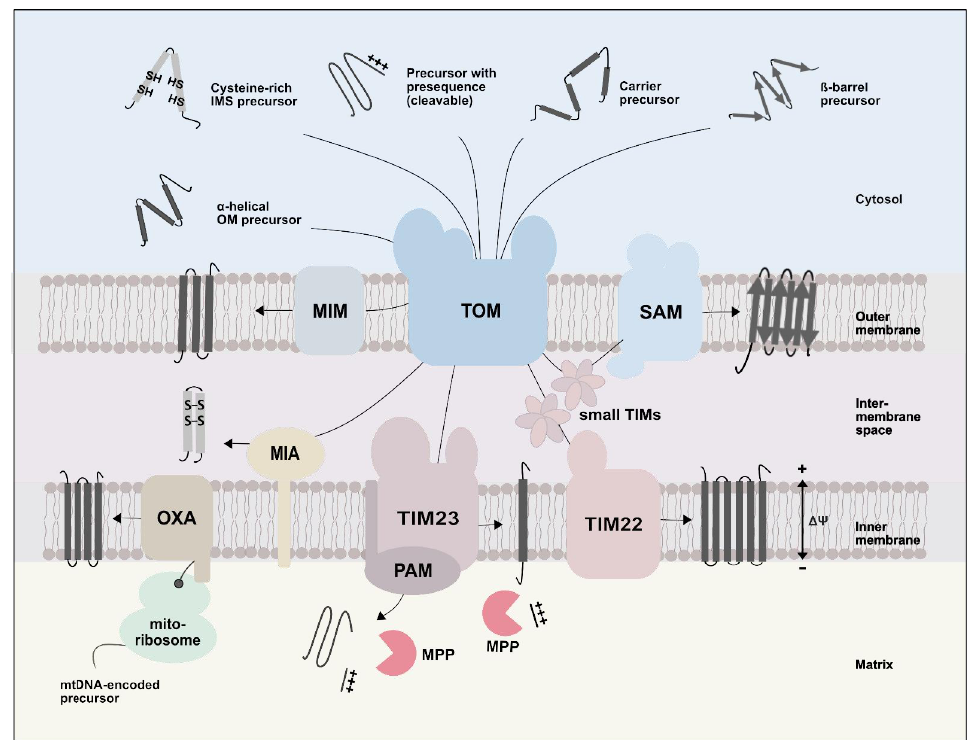
Figure 2. Protein import pathways into mitochondria. Mitochondria have to import the majority of their proteins, which are synthesized as precursors on cytosolic ribosomes. The translocase of the outer membrane (TOM) forms the general entry gate for mitochondrial precursor proteins. After passing the TOM channel, β -barrel precursors are guided by small TIM chaperones of the inter- membrane space to the sorting and assembly machinery complex (SAM), which mediates their fold- ing and insertion into the outer membrane. The presequence translocase of the inner membrane (TIM23) transports precursors with a cleavable presequence into and across the inner membrane. Translocation into the matrix depends on the ATP-depending activity of the presequence trans- locase-associated motor (PAM). After import, mitochondrial processing peptidases (MPP) remove the cleavable presequence. In the carrier pathway, small TIM chaperones transfer the hydrophobic carrier precursor from the TOM complex to the carrier translocase (TIM22), which inserts them into the inner membrane. The membrane potential (Δψ) drives protein import into and across the inner membrane. The mitochondrial intermembrane space import and assembly machinery (MIA) directs cysteine-rich precursors into the IMS and mediates their oxidative folding. The mitochondrial im- port machinery (MIM complex) inserts precursors of single and multi-spanning proteins into the OM. Finally, the oxidase assembly machinery (OXA) inserts mitochondrially encoded proteins into the mitochondrial IM. 4. Role of Lipids in Protein Import into Mitochondria Protein import into mitochondria is modulated by changes in the phospholipid com- position of the mitochondrial membranes (Figure 3). The phospholipid composition is im- portant for the stability and operation of protein translocases and has an impact on dy- namic protein – protein interactions. Phospholipids affect the activity of respiratory chain complexes, which in turn leads to reduced membrane potential and impaired protein